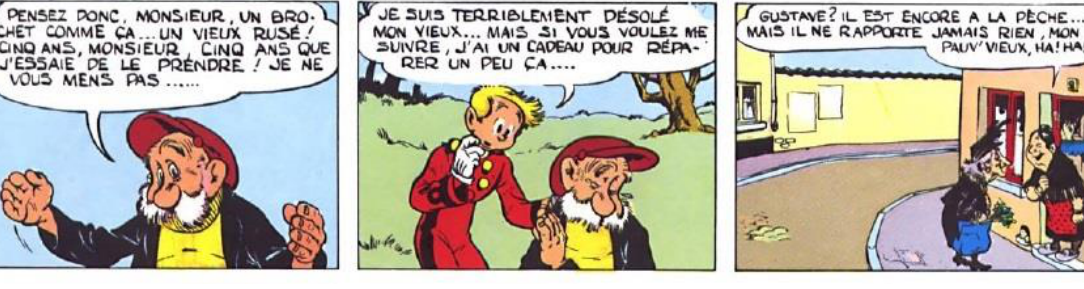
Figure 3 Spirou et Fantasion